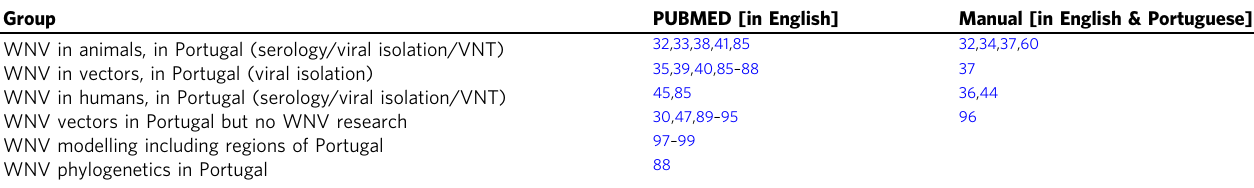
Table 1 Studies including information on WNV or its vectors in